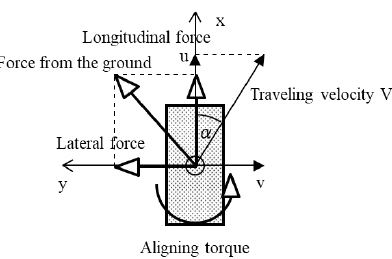
Figure 2. Forces to act on a wheel. The “longitudinal force”, “lateral force”, and “aligning torque” indicate the friction acting on the x- and y-axes and the friction moment around the z-axis, respectively. The slip ratio ( s wi ) and slip angle ( α wi ) of wheel wi are defined as